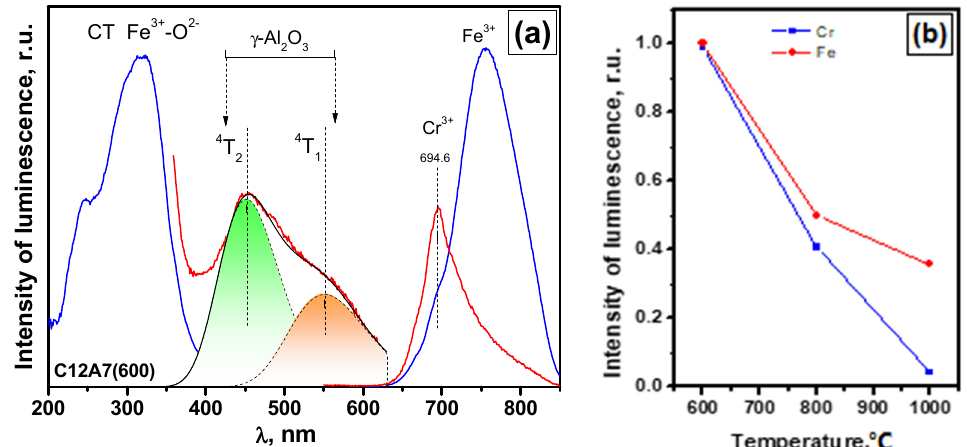
Figure 4. Emission and excitation luminescence spectra of the impurity ions Cr 3+ ( λ ex = 470 nm) and Fe 3+ ( λ ex = 320 nm) in pure mayenite ( a ). Dependence of luminescence intensity of the impurity ions Cr 3+ and Fe 3+ on the calcination temperature ( b ).